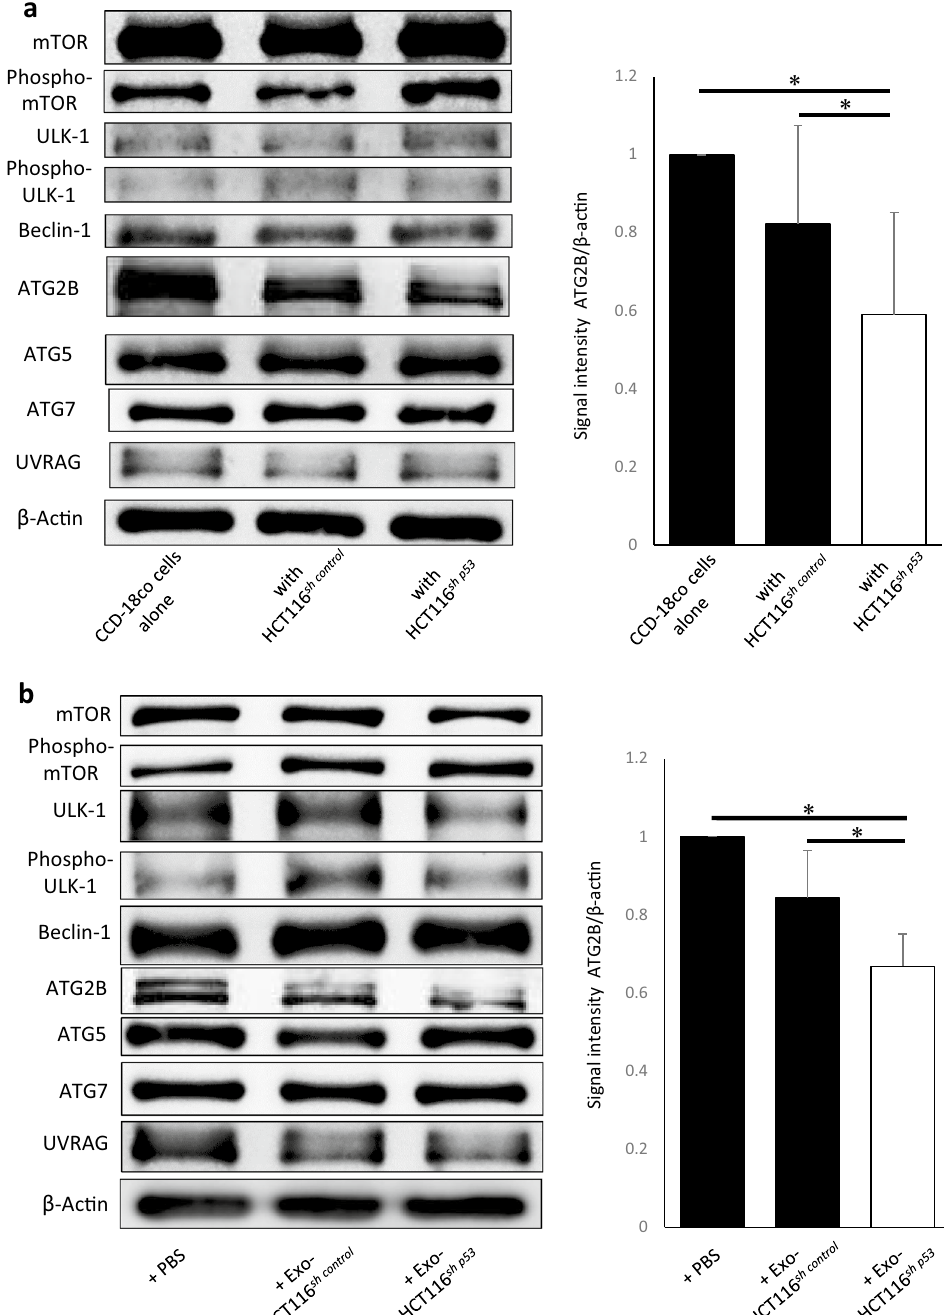
Figure 4. Suppression of ATG2B activates fibroblasts. ( a ) Western blotting analysis of autophagy-related proteins in CCD-18Co cells co-cultured with HCT116 sh control or HCT116 sh p53 cells. Quantification of ATG2B signal intensity ( n = 5, mean ± SD, *P < 0.05). ( b ) Western blotting analysis of autophagy-related proteins in CCD-18Co cells cultured with or without exosomes derived from HCT116 sh p53 or HCT116 sh control cells. Quantification of ATG2B signal intensity ( n = 5, mean ± SD, *P < 0.05). ( c ) ATG2B mRNA expression in CCD- 18Co cells transfected with ATG2B or control siRNA analysed using quantitative real-time PCR (qRT-PCR) (left; n = 3, mean ± SD, *P < 0.05). The expression of ATG2B in CCD-18Co cells transfected with ATG2B or control siRNA analysed using western blotting (right). ( d ) Western blotting and autophagic flux assay in CCD-18Co cells transfected with ATG2B or control siRNA ( n = 4, mean ± SD, *P < 0.05). ( e ) Relative expressions of ACTA2, CXCL12, TGFβ1 , FGF2, RDGFRA and VEGFA mRNA in CCD-18Co cells transfected with ATG2B or control siRNA analysed using qRT-PCR ( n = 3, mean ± SD, *P < 0.05). ( f ) Cell numbers of HCT116 cells co-cultured with CCD-18Co cells transfected with ATG2B or control siRNA for 24, 48, and 72 h. ( n = 3, mean ± SD, *P < 0.05). Protein expression levels were measured using imageJ software 1.8.0_172 (https:// imagej. nih.